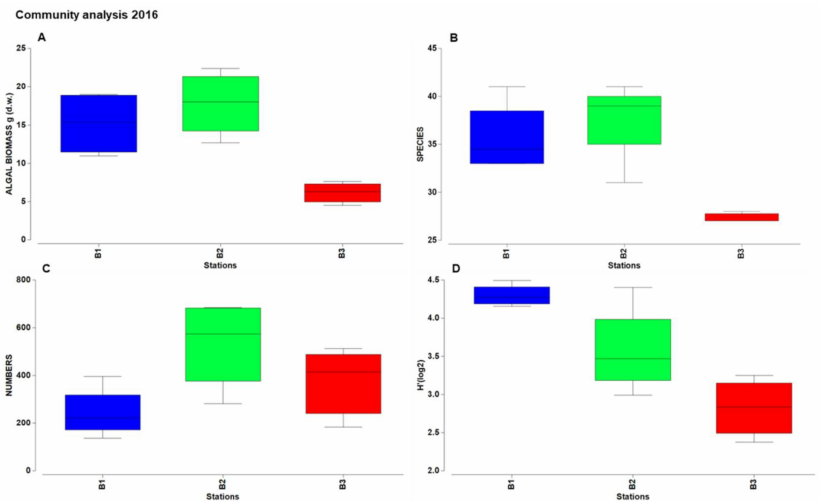
Figure 2. Trend of: ( A ) algal ( Cystoseira brachycarpa ) biomass (g d.w.); ( B ) number of species; ( C ) num- ber of individuals; ( D ) H’ diversity index of benthic invertebrates off the Bottaro crater vent at the three studied stations (B1, B2, and B3) in September 2016.